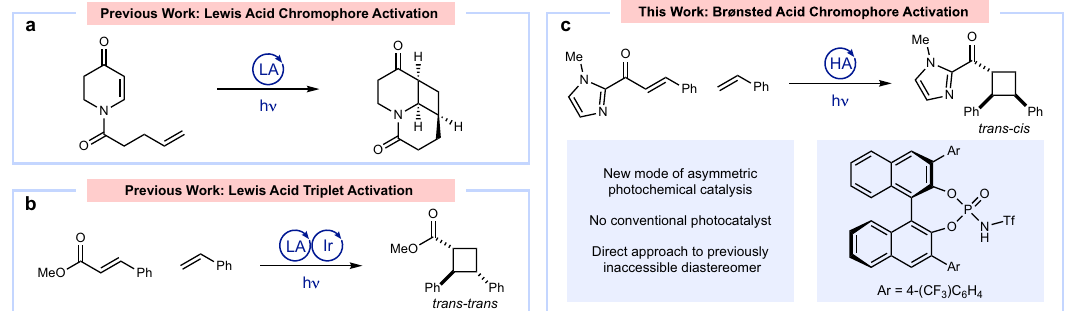
Fig. 1 Asymmetric acid-catalyzed photoreactions. a Intramolecular [2 + 2] photocycloadditions via Lewis acid-catalyzed chromophore activation; LA = Lewis acid. b Intermolecular [2 + 2] photocycloadditions via Lewis acid-catalyzed triplet activation. c Intermolecular [2 + 2] photocycloadditions via Bronsted acid-catalyzed chromophore activation. HA = Brønsted